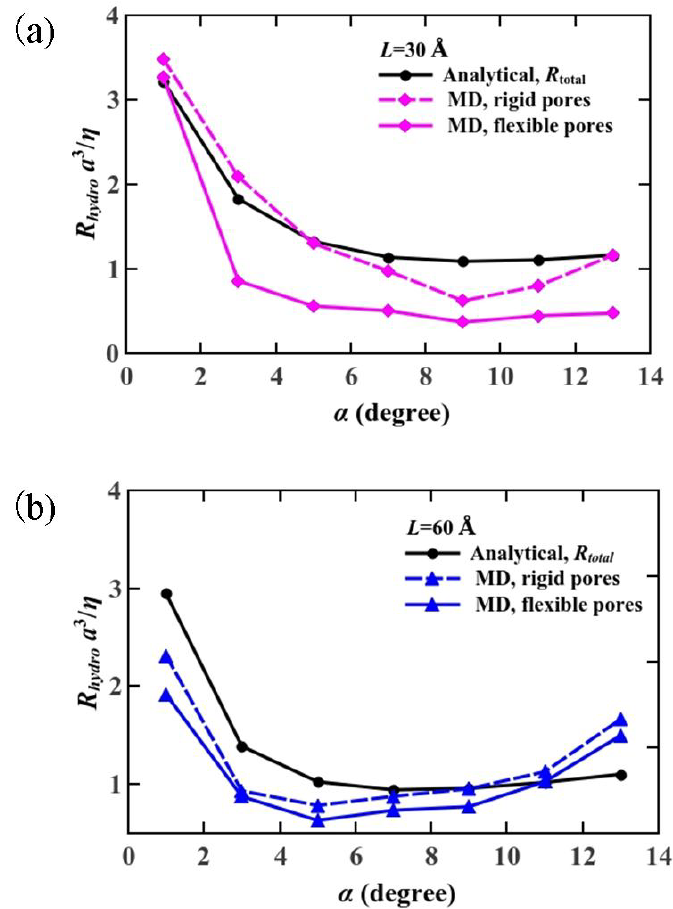
Figure 5. Comparison of the hydrodynamic resistance from analytical model and that from the molecular dynamics simulations ( a ) L = 30 Å; ( b ) L = 60 Å.